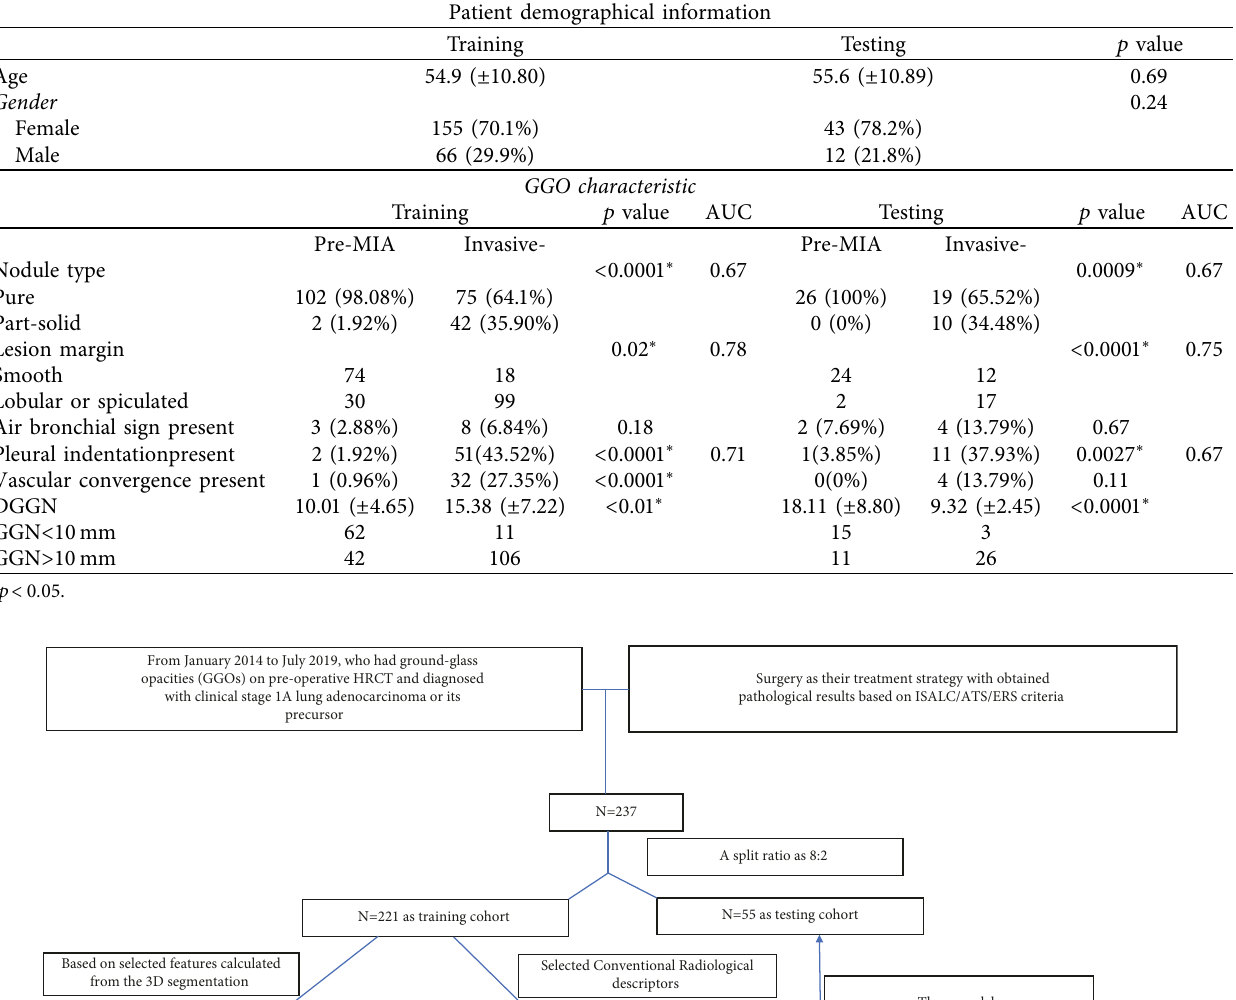
Table 1: Patient demographic information comparison between the training and testing cohorts and semantic imaging feature comparison between the invasiveness subtypes and differentiation ability in terms of